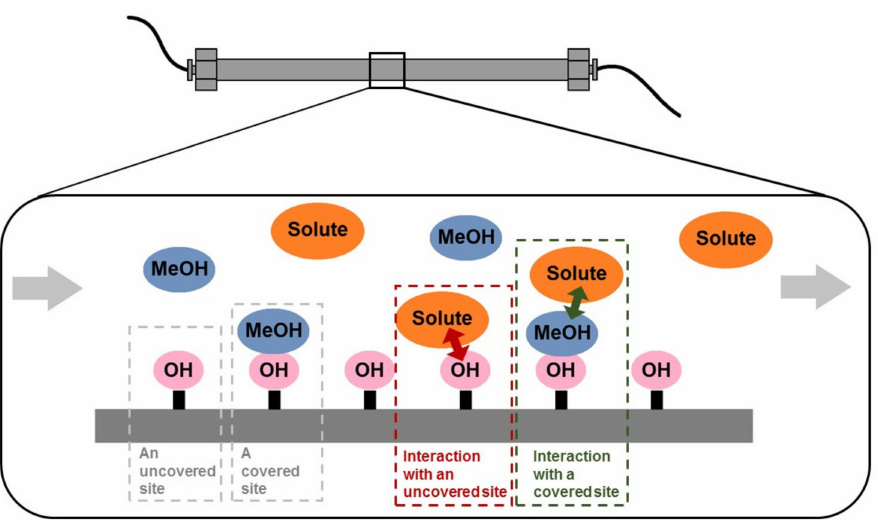
Figure 1. A schematic diagram of the mixed retention mechanism in a silica-packed column. The in- teraction in the green dashed line contributes to k c in Equation (11) and the interaction in red dashed line contributes to k 0